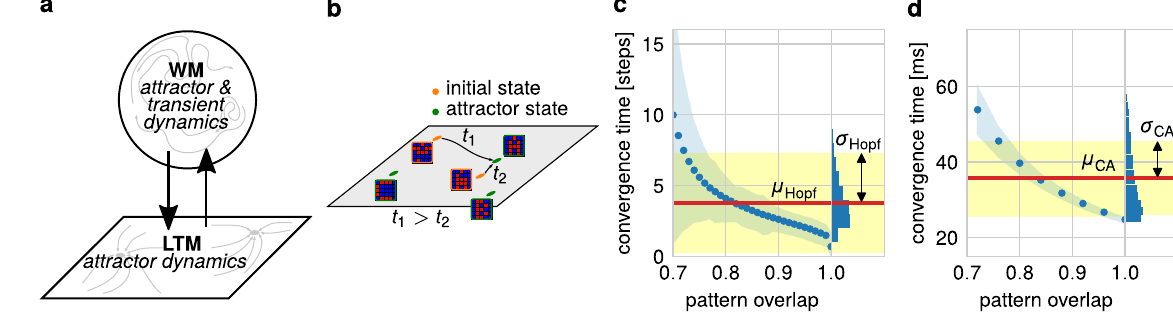
Figure 7. Network models of long-term memory show variances in recall timings. ( a ) As WM and LTM interact continuously, inherent properties of the LTM network influence the function of WM. ( b ) In standard network models of LTM, the recall of a memory representation (e.g., the letter “A”) corresponds to the convergence of the neuronal system dynamics to a previously learned attractor (green dots). The time span required until convergence (“convergence time”; here t 1 and t 2 ) depends on the initial state of the system or the recall stimulus (differently altered “A”s; orange dots). (c) 100 random patterns are stored into a standard Hopfield network 43 with N Hopf = 1000 neurons. Patterns with differences in d neurons to one of the stored patterns, corresponding to a pattern overlap of 1 − d / N Hopf , are used as initial states for the system. The number of simulation steps to reach the stored pattern represents the convergence time (dots mark average value over 10000 trials with standard deviation indicated by blue shading). The histogram on the right-hand side illustrates the resulting distribution of convergence times for a uniform distribution of initial pattern overlaps (red line shows mean μ Hopf and yellow shading the corresponding standard deviation σ Hopf ). (d) The recall convergence times analyzed similar to panel (C) for a self-organizing cell-assembly network 28 . A cell assembly is trained to represent a given input pattern. After training, a similar pattern with an overlap of 1 − d / N aff , is presented to the network (i.e. d neurons have a different activity compared to the learned pattern). The time span required to activate 90% of the cell assembly represents the convergence